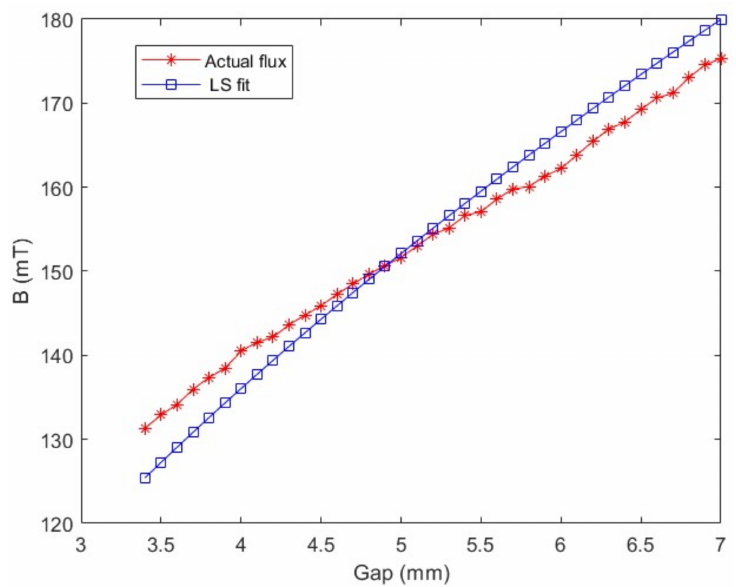
Figure 7. Comparison of the actual magnetic flux and the magnetic flux estimated by Equation